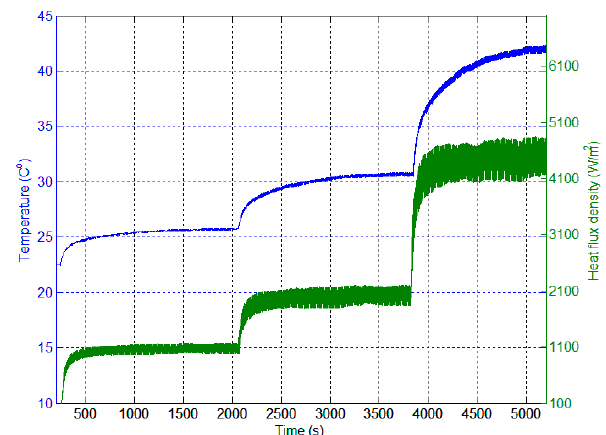
Figure 10. Heat flux density and case temperature in three steady state conditions measured at 15, 30, and 60 A switching current with fundamental and switching frequency of 0.1 Hz and 1 kHz, correspondingly.